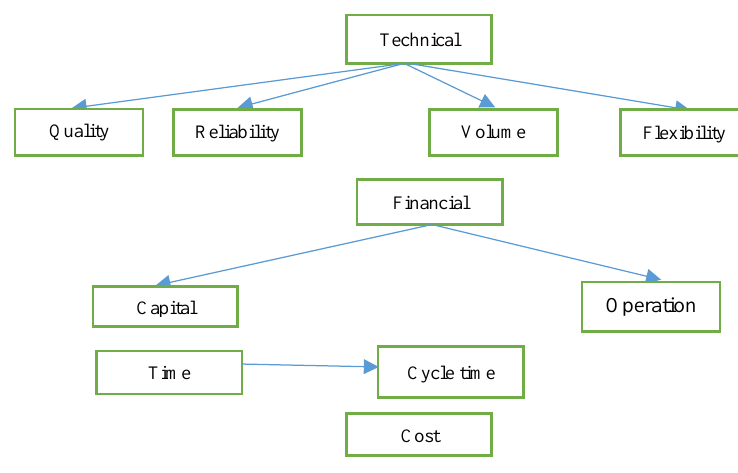
Figure 1. Technology transfer